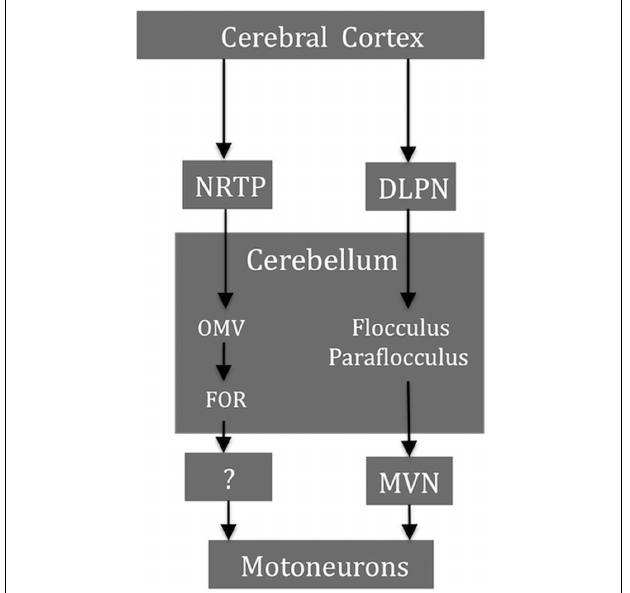
FIGURE 6 | Some smooth pursuit-related structures and their major projections. The brain stem afferents form the DLPN project more strongly to the flocculus/paraflocculus and the NRTP afferents mainly terminate in the OMV region. Cerebellar output from the flocculus/paraflocculus to the ocular motoneurons relays through the MVN whereas the projections from the OMV/FOR are not known. NRTP, nucleus reticularis tegmenti pontis; DLPN, dorsolateral pontine nuclei; OMV, oculomotor vermis; FOR, fastigial oculomotor region; MVN, medial vestibular